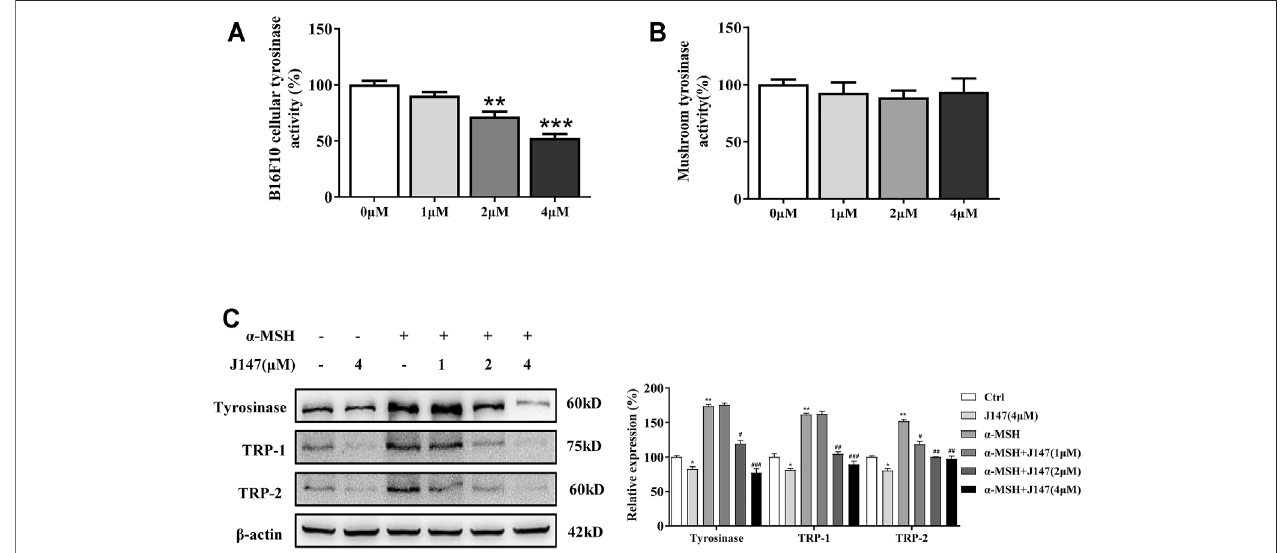
FIGURE 2 | Effect of J147 on the expression of tyrosinase and the activity of tyrosinase. (A) Cellular tyrosinase activity was determined by L-DOPA oxization as described inmethods. (B) Mushroom tyrosinase activity was determined asdescribedin methods. (C) B16F10cells were treated with J147 inthe presence or absence of α -MSH(60 nM)for48 hand westernblotwasthen applied todetectthetyrosinase,TRP-1 andTRP-2 levels. Dataareexpressed asthemean ± SD( n (cid:2) 3). * p < 0.05, ** p < 0.01, *** p < 0.001 vs. non-treated cells. # p < 0.05, ## p < 0.01, ### p < 0.001 vs. α -MSH-treated cells.